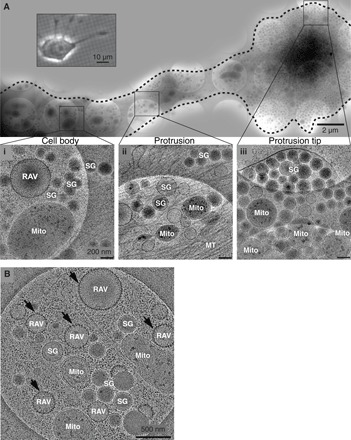
Distribution of RAVs in the cell periphery.INS-1E cells were grown directly on EM grids. (A) Overview cryo-EM image of a thin protrusion extending from the periphery of the cell body and containing accumulations of secretory granules, ribosomes, and cytoskeleton. Scale bar, 2 μm. Inset shows a representative phase-contrast image of an INS-1E cell grown on an EM grid; this image is from a different cell than the one imaged in the remainder of the figure. Scale bar, 10 μm. (i) At the junction between the cell body and the protrusion, there are accumulations of mitochondria, small dense-core secretory granules, and RAVs. (ii) Extensive microtubule tracks run lengthwise along the protrusion and appear to transport secretory granules and mitochondria toward (iii) the expanded tip of the protrusion. These tips are packed with mature dense-core secretory granules and mitochondria and are absent of RAVs. Scale bars, 200 nm. (Note that white circles correspond to 2-μm holes of the QUANTIFOIL holey carbon film onto which the cells are attached). (B) An additional view of the same junctional region between the cell body and protrusion highlighted in (i) featuring an abundance of RAVs (indicated by arrows) and free, cytoplasmic ribosomes. Scale bar, 500 nm. Pixels on the detector represent 2.6 Å at the specimen level; images are montaged in the overview with nonmontaged images in the remaining panels. Images are representative of n > 3 independent experiments.